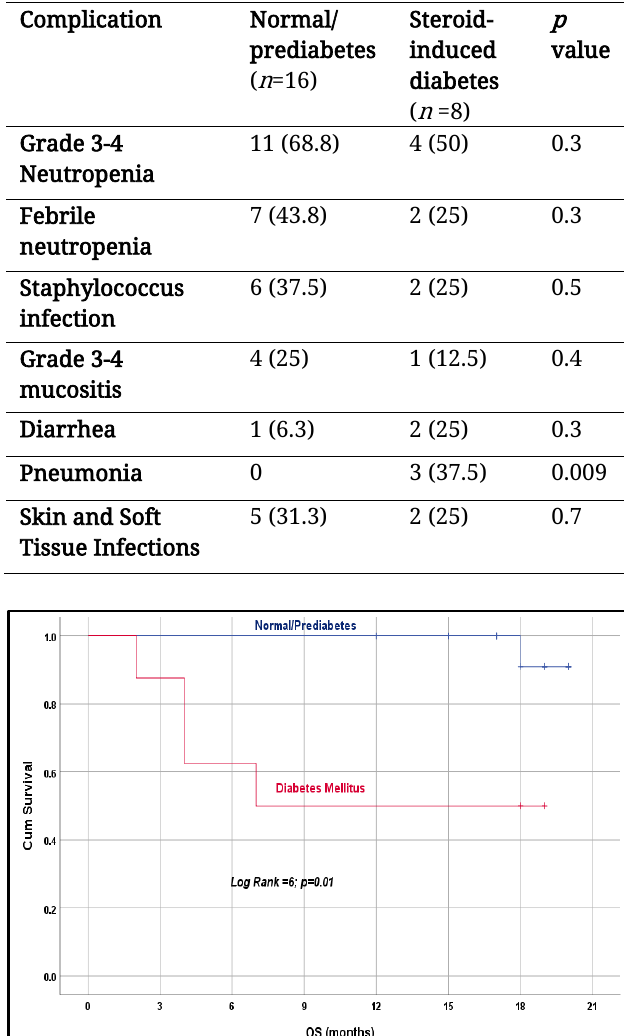
Table 4: Comparing complications between normal/ prediabetic patients and those with steroid-induced diabetes in the non- Hodgkin’s lymphoma group